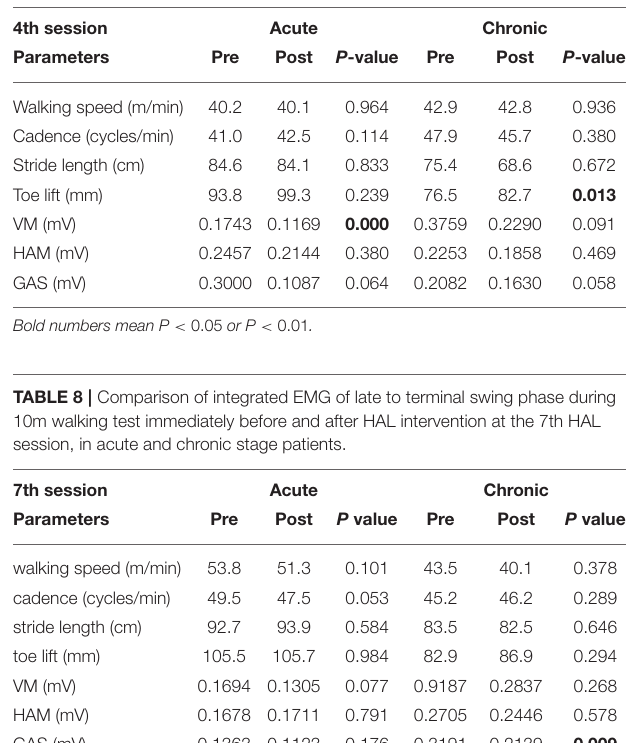
TABLE 7 | Comparison of integrated EMG of the late to terminal swing phase during 10m walking test immediately before and after HAL intervention at the 4th HAL session, in acute and chronic stage patients.